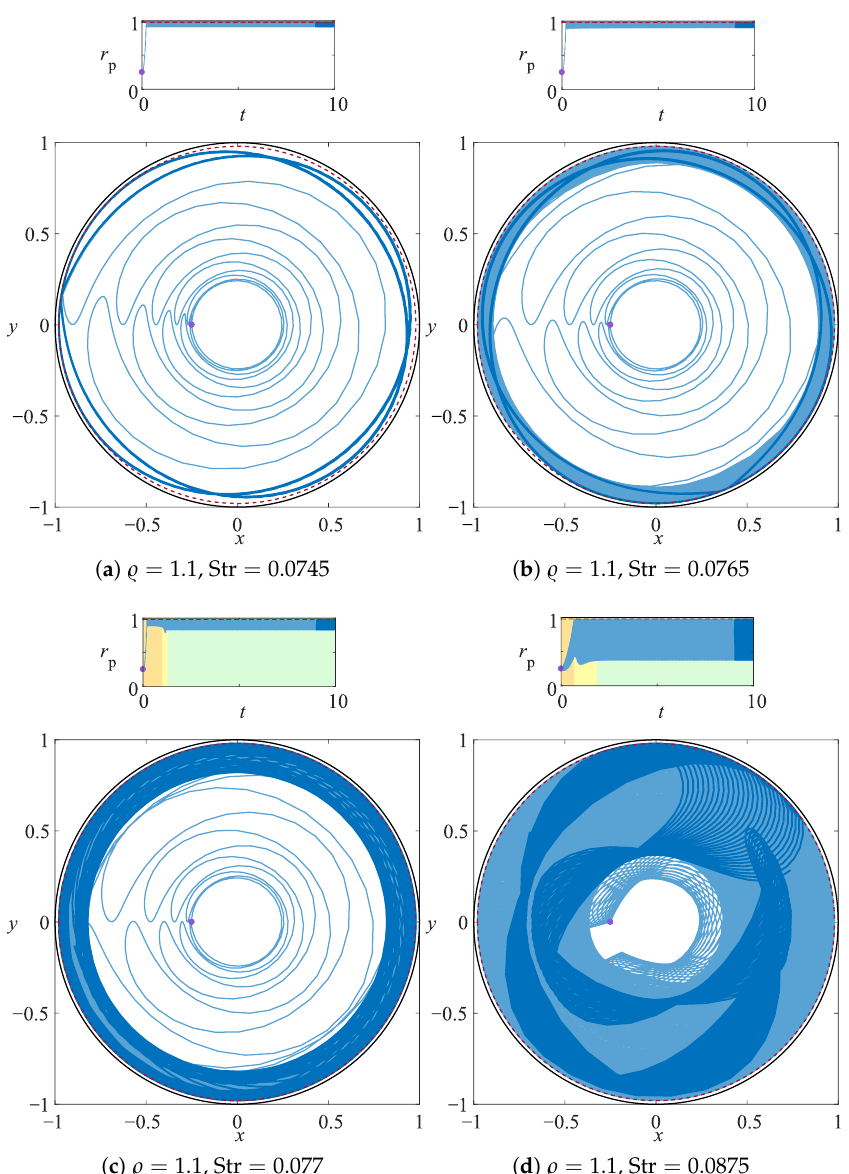
Figure 6. Radial coordinate r p of a particle trajectory for (cid:36) = 1.1, St = 1 and Str = 0.0745, 0.0765, 0.077, and 0.0875. The trajectories are integrated for t = 10 and they are denoted by the light-blue line. The darkblue solid line shows the last 10% of the particle orbit and the purple dot its initial position. The red dashed line identifies the sliding surface of the PSI model, which surface is at distance ∆ = a from the driving boundary. The orange background denotes the particle attraction phase to a quasi-steady unstable attractor, the yellow background highlights the transition phase and the green background shows the orbit attraction to the stable traveling